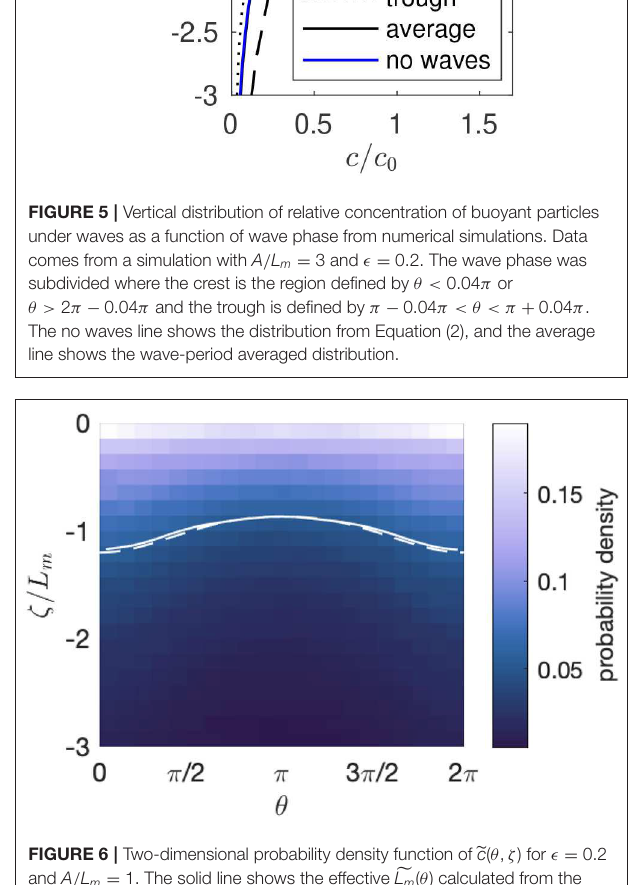
FIGURE 6 | Two-dimensional probability density function of and A / L m 1. The solid line shows the effective = numerical simulations, and the dashed line shows Equation